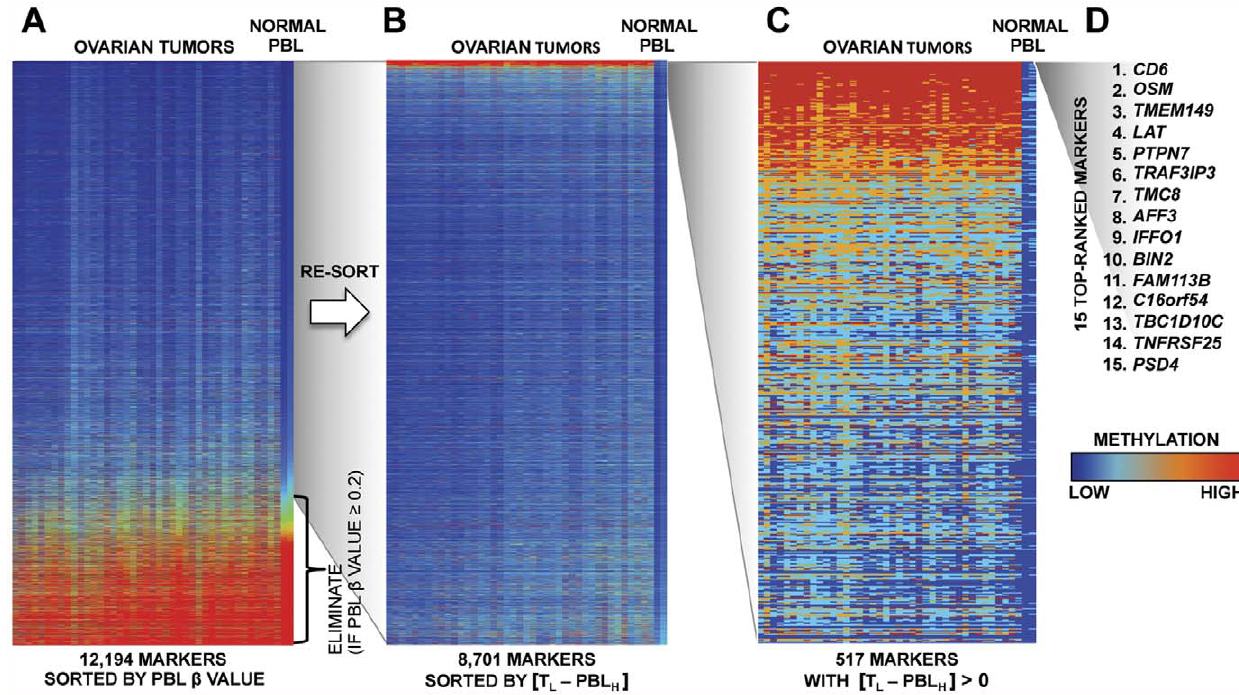
Figure 2. Heat map representation of the marker selection process. A, the 12,194 markers remaining after the elimination of the probes that failed in any of the samples, and of the probes containing SNPs or repetitive elements. Markers are ranked in an ascending order based on the mean DNA methylation b value of the two PBL samples. B, the 8,701 markers remaining after eliminating probes with DNA methylation b values $ 0.2 in any of the two PBL samples. Probes were ranked in a descending order based on the difference in DNA methylation between the tumor with the lowest b value (T L ) and the PBL sample with the highest b value (PBL H ). C, the 517 markers with higher DNA methylation values in any of the tumor than in any of the PBL samples. The markers are ranked in a descending order based on the difference between the tumors and the PBL DNA methylation values. D, the top-ranked 15 markers that were transitioned to the MethyLight platform for further verification.